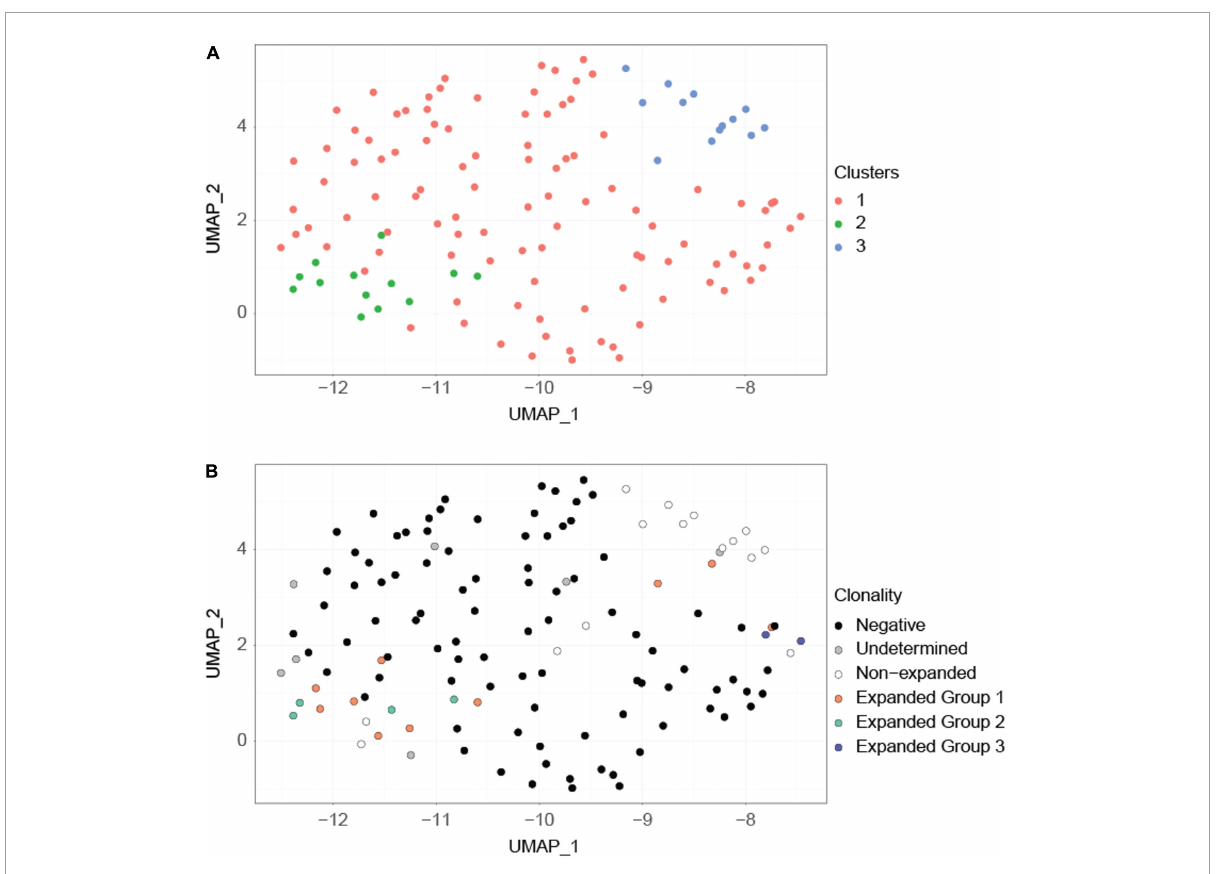
FIGURE3 Clustering based on transcriptional profiles correlates with clonality. (A) UMAP projection of the cells. This projection is based on the first 8 principal components of the normalized imputed expression data of the highly variable genes. Graph-based clustering revealed three major clusters (orange, green, blue). (B) The same UMAP projection but with cells labeled according to their clonotypes. Expanded P6 + cells are separated into three clonotypes (orange, green, blue) based on their productive and non-productive TCR α and TCR β chains. Expanded group 3 (blue) cells are separated from the remainder of the expanded P6 + cells. Undetermined cells are cells for which TCR information is